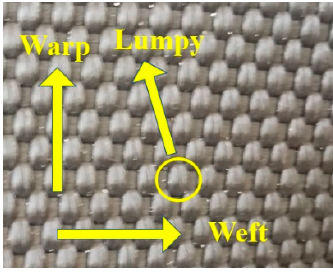
Figure 1. Surface of woven polypropylene fabric.